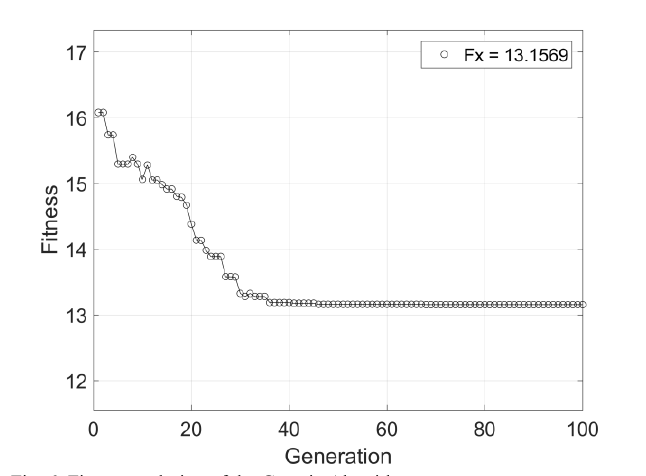
Fig. 6. Fitness evolution of the Genetic